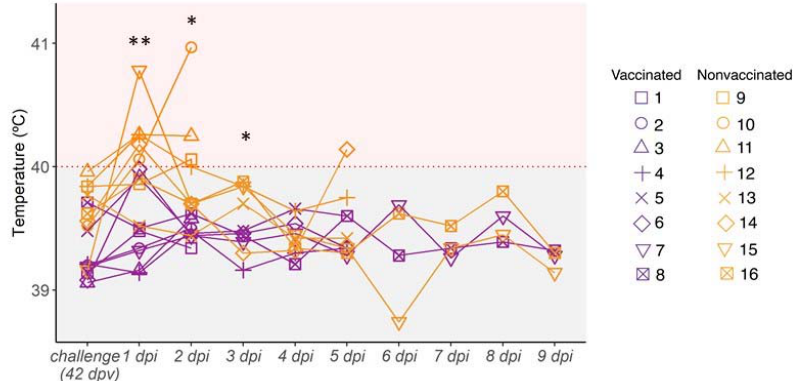
Figure 3. Kinetics of rectal temperature after H3N2 SIV challenge. Pigs are considered to have fever with temperatures greater than 40 °C (red dashed line). Vaccinated animals are represented in violet whereas nonvaccinated ones are represented in orange. Each line represents the rectal temperature measured in each pig over time; (*) p ≤ 0.05 and (**) p ≤ 0.01.